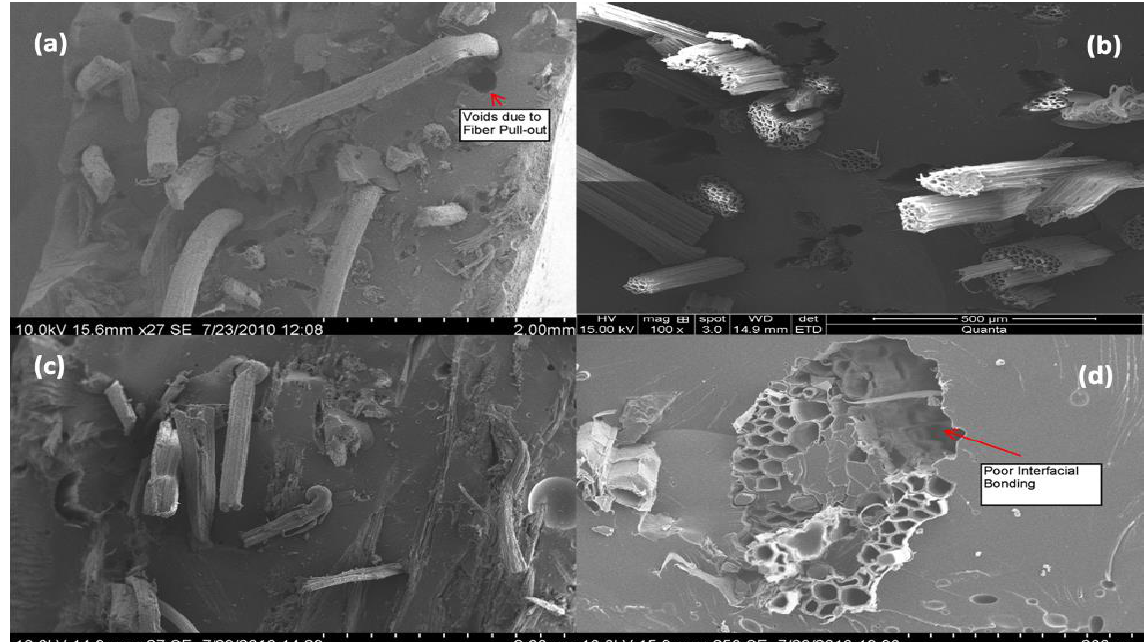
Figure 3. SEM micrographs of fractured surfaces: ( a ) fibre pull-out during the tensile test; ( b ) cluster of bundles during the flexural test; ( c ) fibre breakage during the impact tests; ( d ) poor interfacial bonding [56] (reprinted with permission from Elsevier, License Number: 5446961080043).